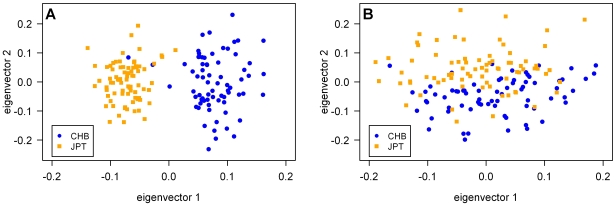
The top two axes of variation from principal component analysis of JPT and CHB.Results from EIGENSTRAT were based on (A) 420 putative AIMs selected by comparing the MEC-J pools to the CHD population from HapMap phase 3 and (B) 420 random SNPs. Differentiation between JPT and CHB is clear when using the set of putative AIMs, compared to that using the same number of random SNPs. Note that the two CHB individuals within the JPT cluster in (A) would also cluster with JPT individuals if genome-wide data were used (data not shown). Similar differentiation using random SNPs could also be achieved when ∼3,100 random SNPs were used (data not shown).